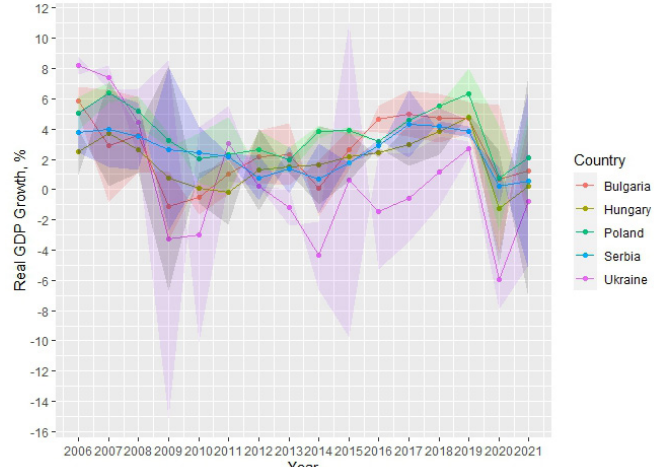
Figure 4. Fitted values of models, Hypothesis 1 (correlation between budget deficit, public debt and real GDP growth), with standard error